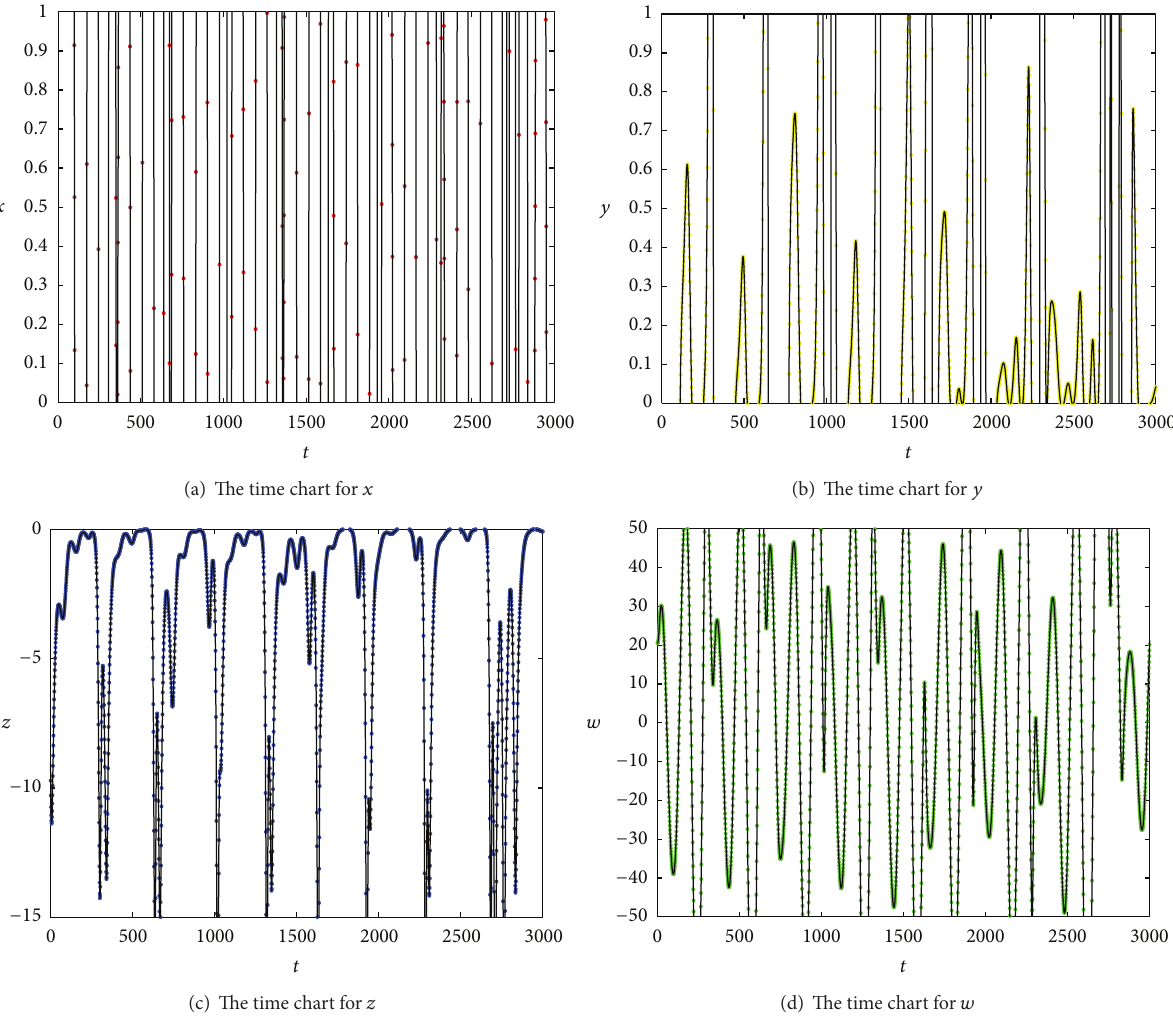
Figure 10: The time charts of the system with 𝑥 = 11.28 , 𝑦 = −11.21 , 𝑧 = −9 , and 𝑤 = 20.49 and 𝑎 = 0.98 , 𝑏 = 12 , 𝑐 = 6 , 𝑑 = 0.06 , and 𝑒 = 20